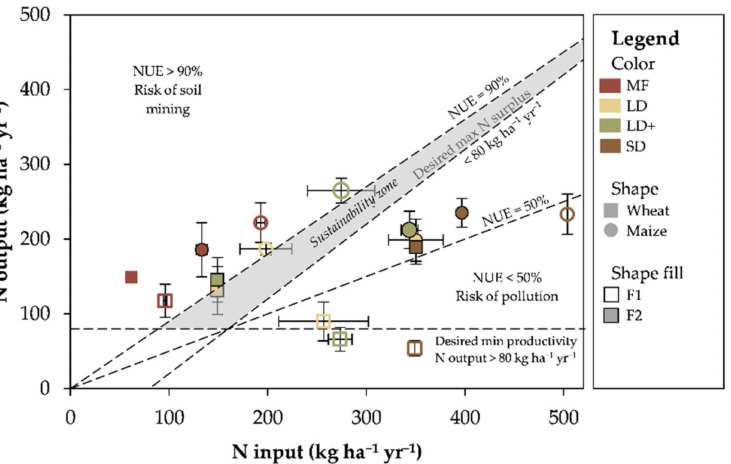
Figure 5. Graphical presentation of the Nitrogen Use Efficiency (NUE) as results of the N input vs. N output. The lines corresponding to NUE = 90%, desired maximum surplus = 80 kg ha − 1 yr − 1 , NUE = 50%, and desired minimum productivity = 80 kg ha − 1 yr − 1 des- ignate the “sustainability” zone (in grey). For further details please see the EU Nitrogen Expert Panel (2015). Error bars represent the standard